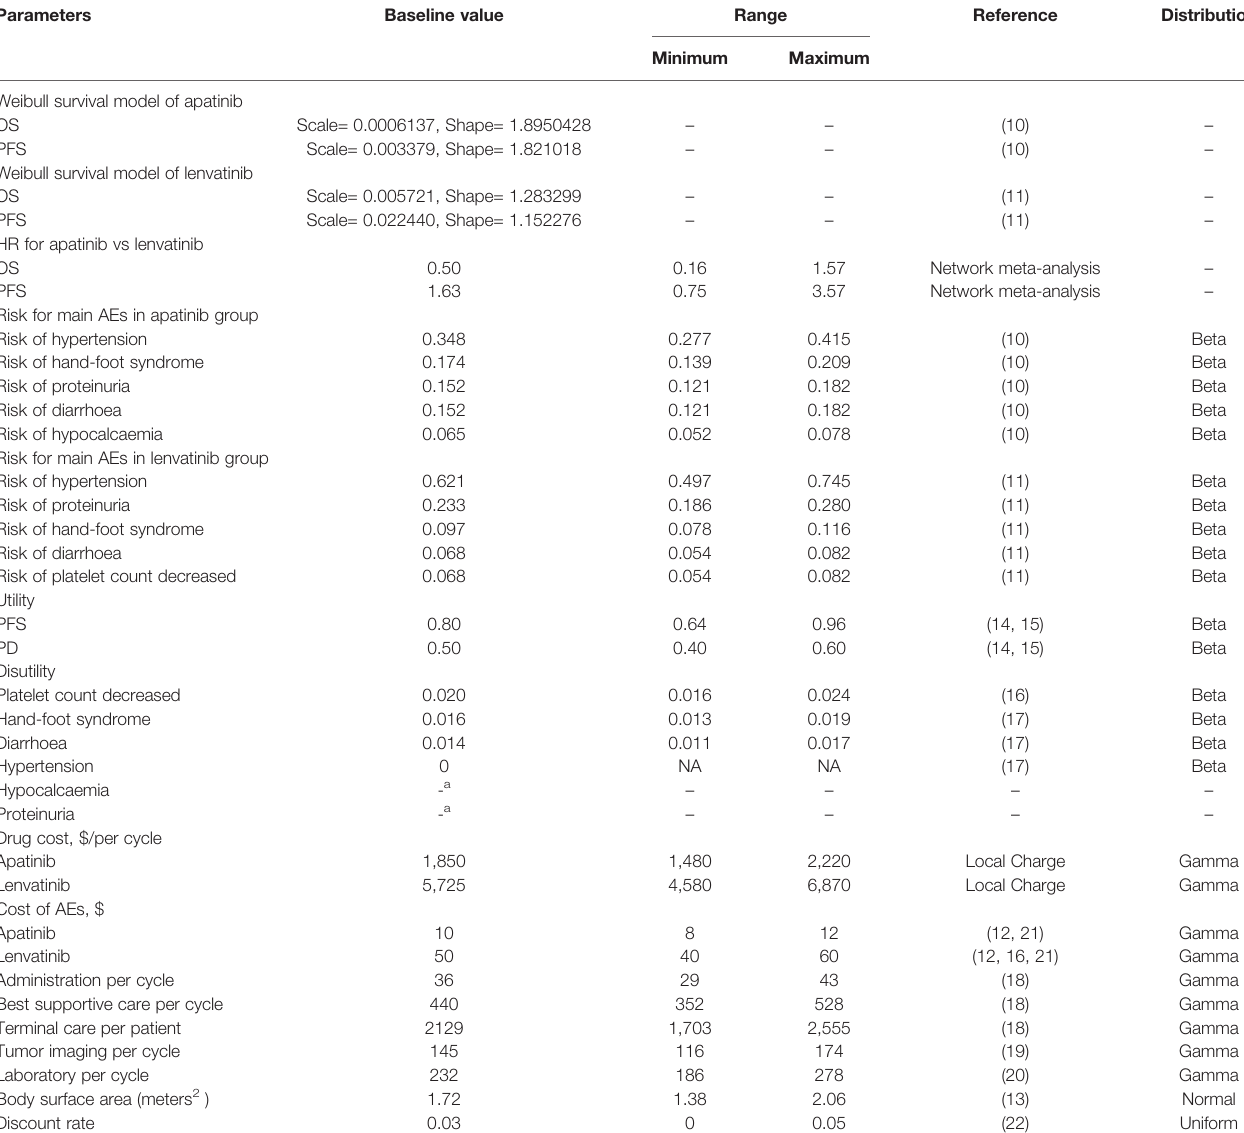
TABLE 1 | Model parameters: baseline values, ranges, and distributions for the sensitivity